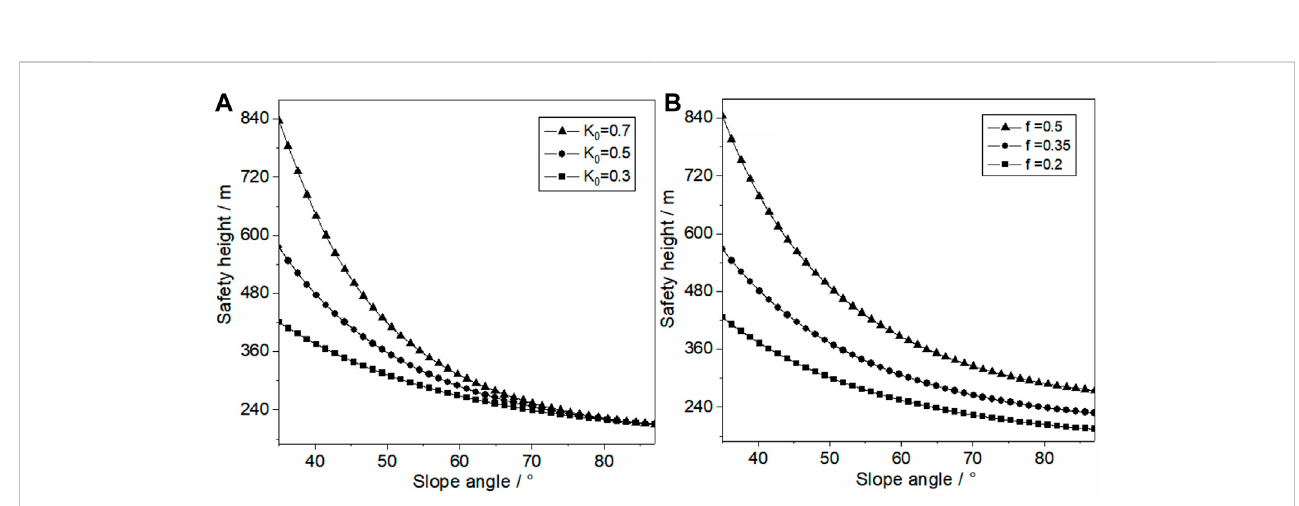
FIGURE 10 Variationintheslopesafetyheightwiththeslopedipangle: (A) in fl uenceoftheside-pressurecoef fi cientand (B) in fl uenceoftheside-frictioncoef fi cient.